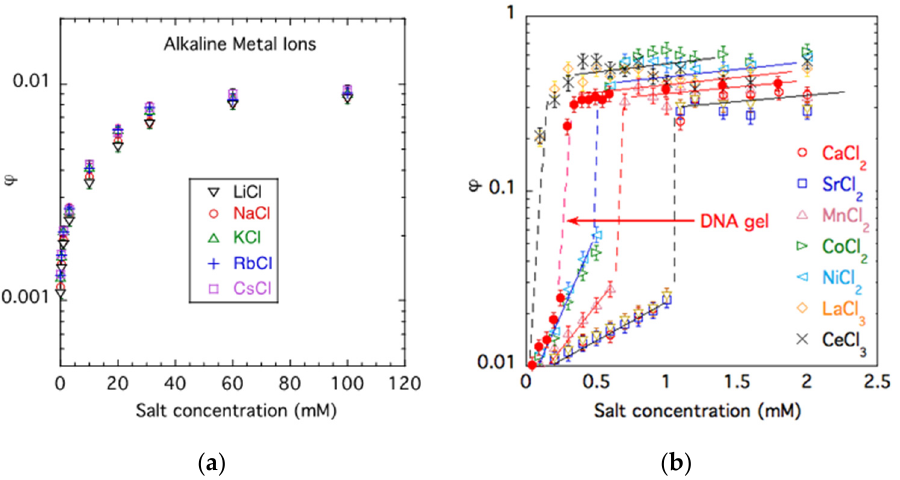
Figure 1. Effect of different monovalent ( a ) and multivalent salts ( b ) on the volume fraction ϕ of PA gels. Filled symbols show the dependence for a DNA gel. In ( b ), measurements were conducted in solutions containing 40 mM NaCl. Curves are a guide for the eye.